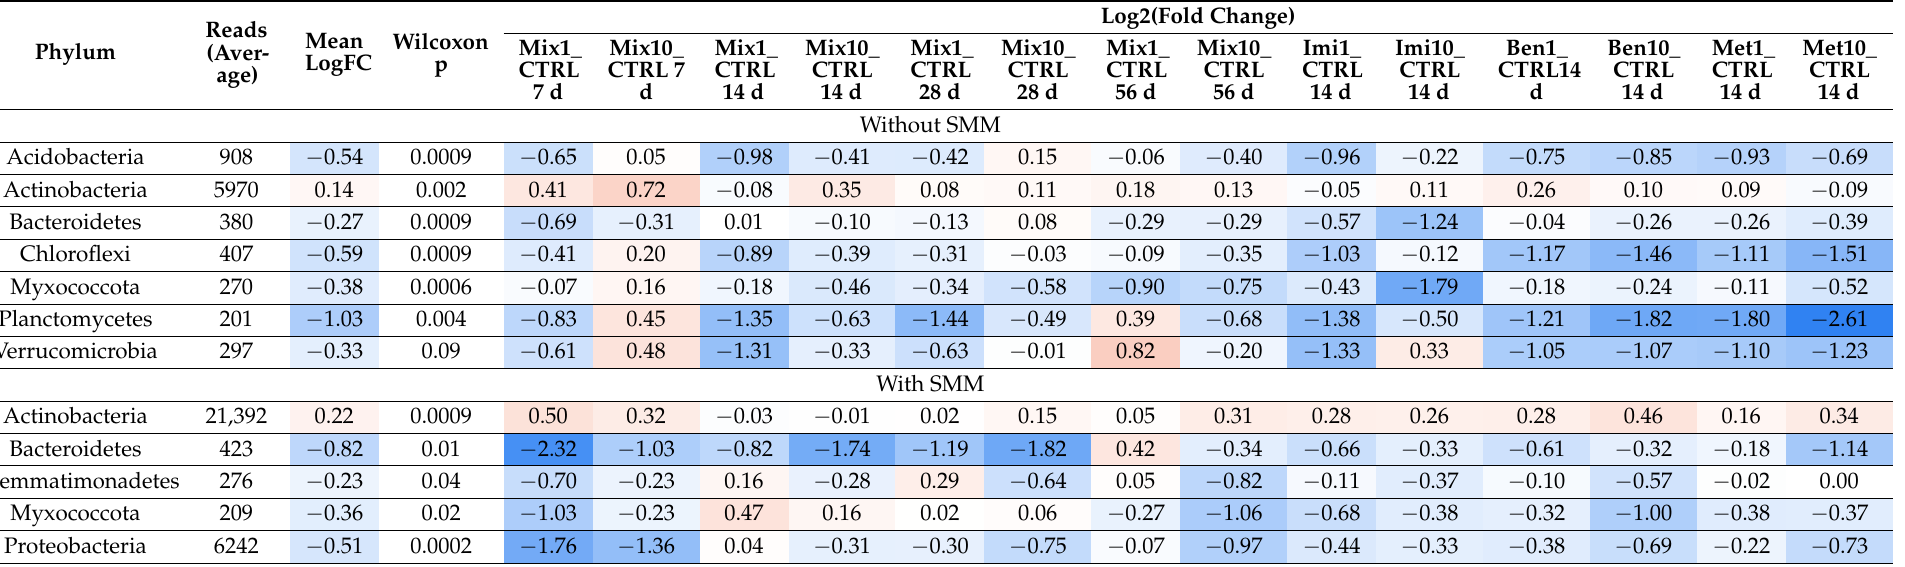
Table 7. Pairwise comparison of abundances of various bacterial phyla between control and treated soil